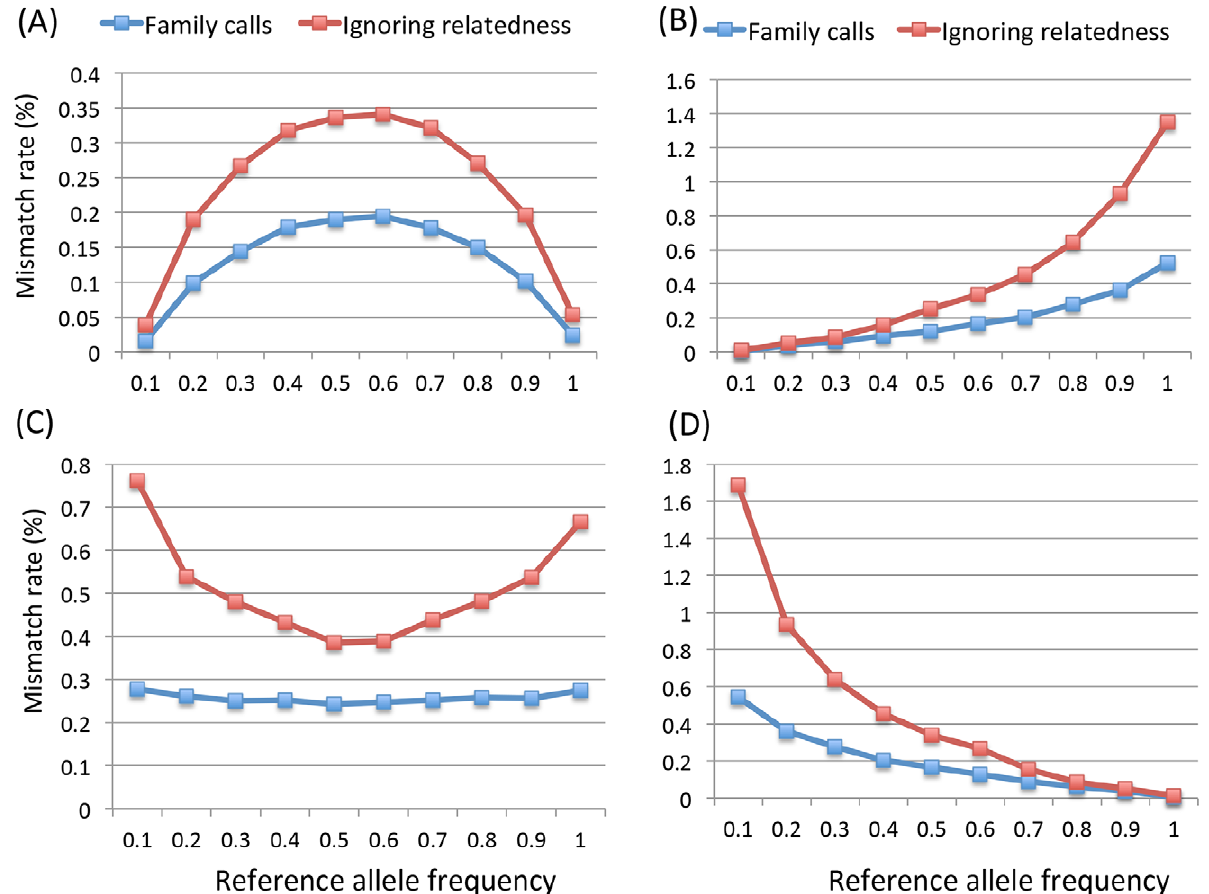
Figure 2. Mismatch rates (%) of 4 categories of genotypes by the reference allele frequencies for pedigrees of quartet (two siblings and their parents) with base quality Q20 at 15 6 without mapping error. The 4 categories are (A) overall genotypes, (B) homozygous alternative allele, (C) heterozygotes and (D) homozygous reference allele.